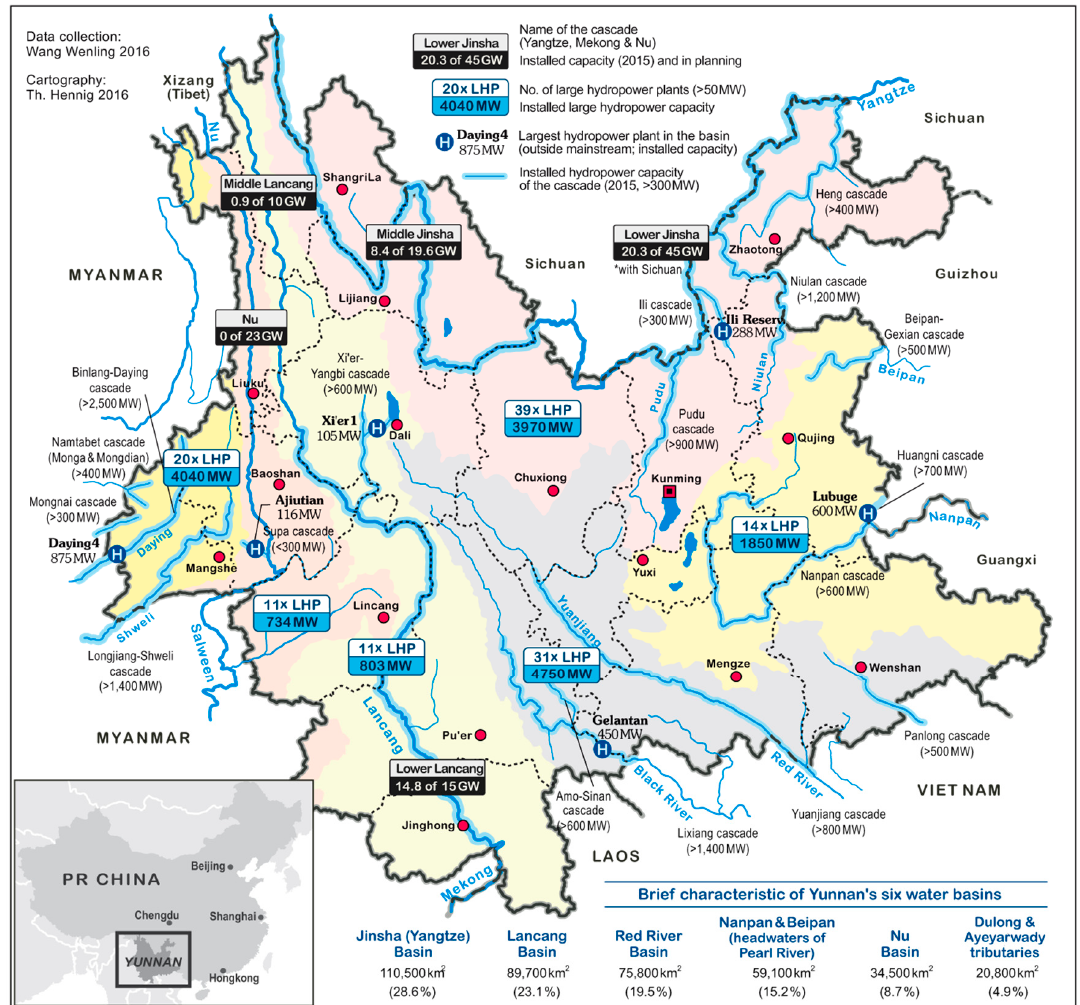
Figure 4. Overview of Yunnan’s large hydropower development in its six river basins.